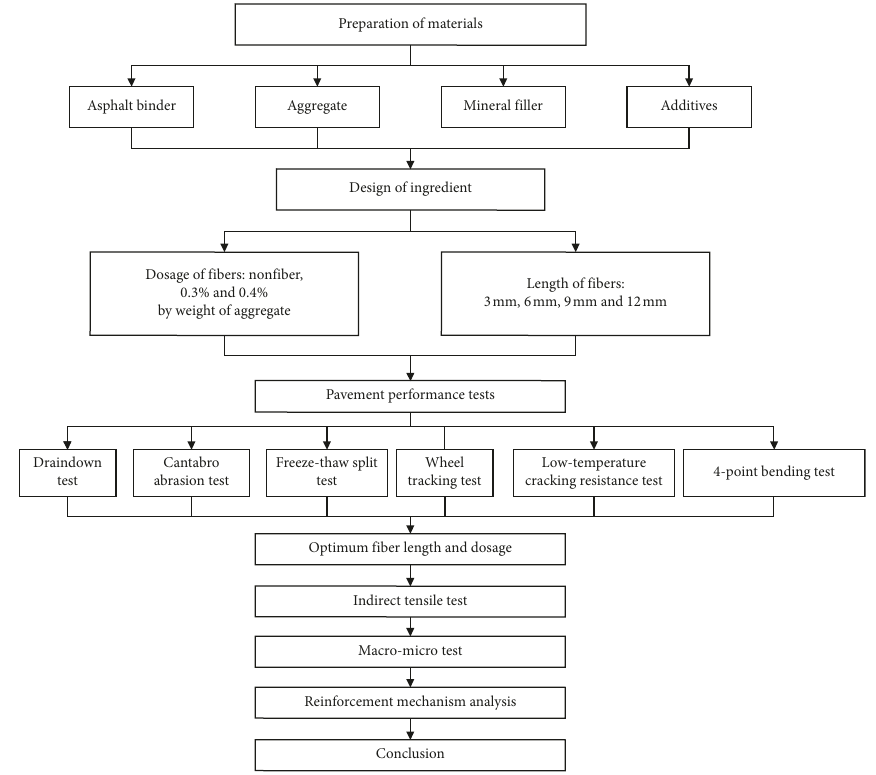
Figure 4: Flowchart of test methods.